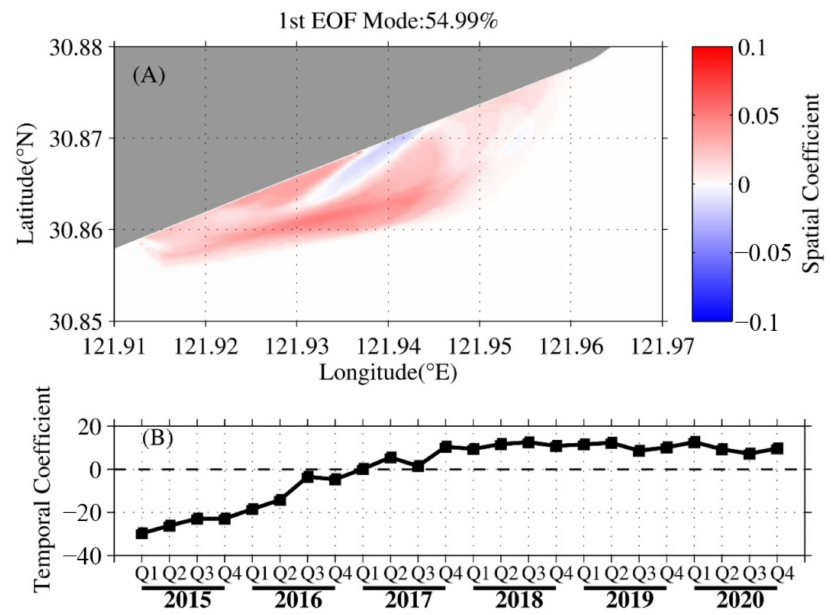
Figure 10. ( A ) First EOF spatial pattern and ( B ) the associated temporal coefficients. Red and blue represent the opponent phases. In detail, accretion occurred in the blue regions when erosion occurred in the red regions, and vice versa. Q1, Q2, Q3, and Q4 are the four quarters of each year (the same